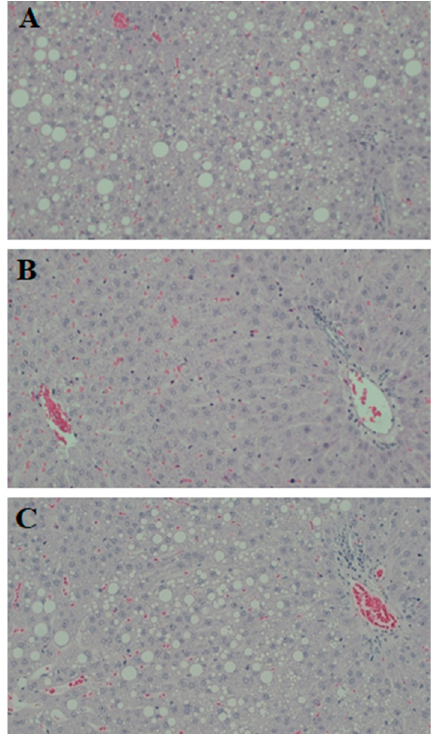
Figure 3. Representative hematoxylin and eosin-stained histological sections of rat liver: ( A ) Samples from the control group showing marked fatty change. There is mixed small- and large-droplet macrovesicular steatosis affecting most hepatocytes. There is no ballooning, inflammation or fibrosis. ( B ) Rat liver sample from the coffee group showing normal morphology with no significant steatosis. ( C ) Marked steatosis, predominantly large-droplet macrovesicular, in most hepatocytes without ballooning, inflammation, or fibrosis in a random sample from the nutraceuticals group.